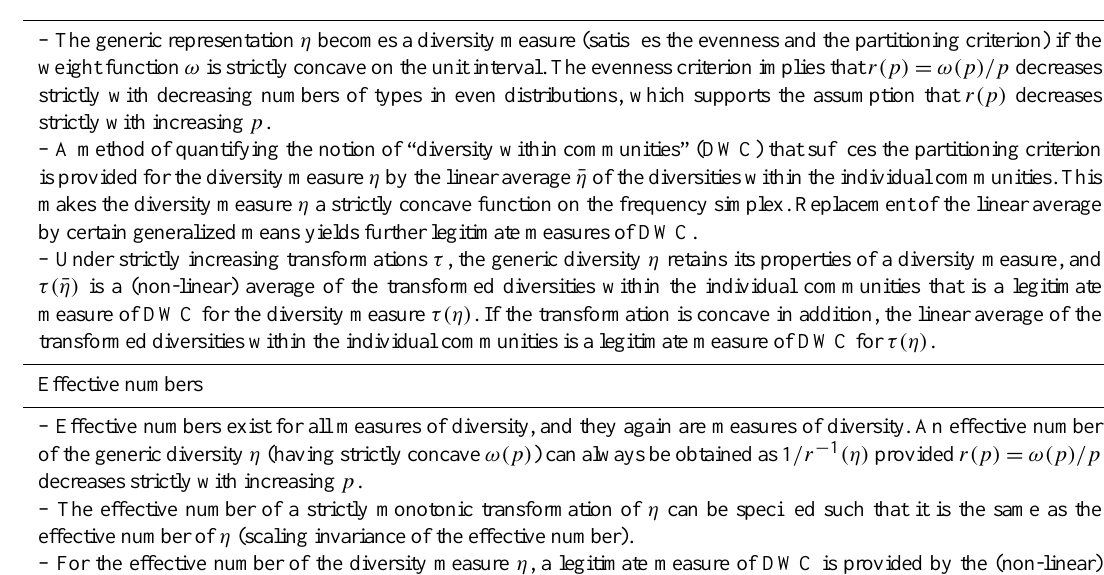
Table 2. Summary of properties of the generic diversity η = P i ω(p i ) . – The generic representation η becomes a diversity measure (satisfies the evenness and the partitioning criterion) if the weight function ω is strictly concave on the unit interval. The evenness criterion implies that r(p) = ω(p)/p decreases strictly with increasing p